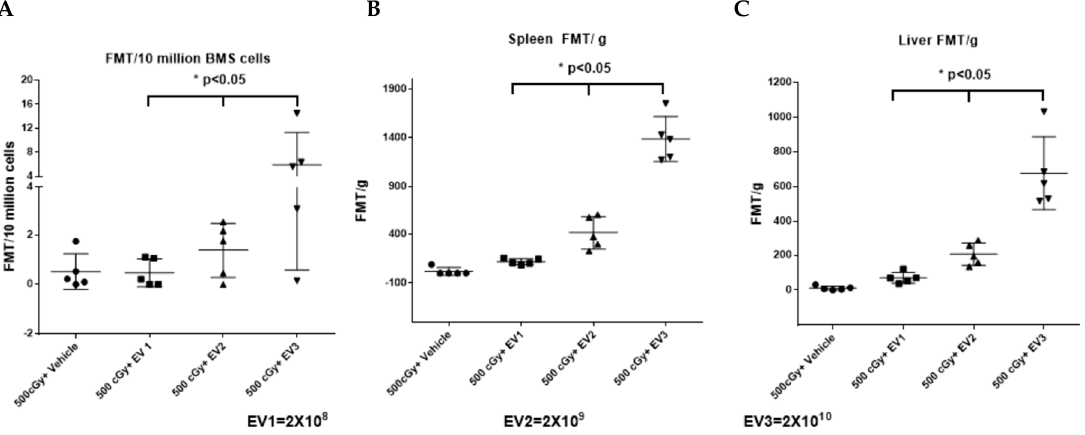
Figure 6. A dose-dependent increase in tissue uptake in mice by systemically administrated EVs in the ( A ) bone marrow, ( B ) spleen, and ( C ) liver. The intensity of fluorescence was expressed as the average of fluorescence intensity (count/energy)/weight of tissue or 10 million bone marrow cells ± SEM, n = 5/group. One-way ANOVA with a multi-comparison test was performed to evaluate the fluorescence intensities in bone marrow, spleen, and liver tissues from animals that received three different doses of EV respectively. * p < 0.05.